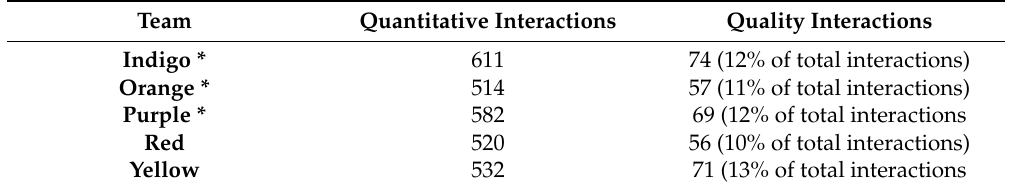
Table 9. Total quantitative and quality